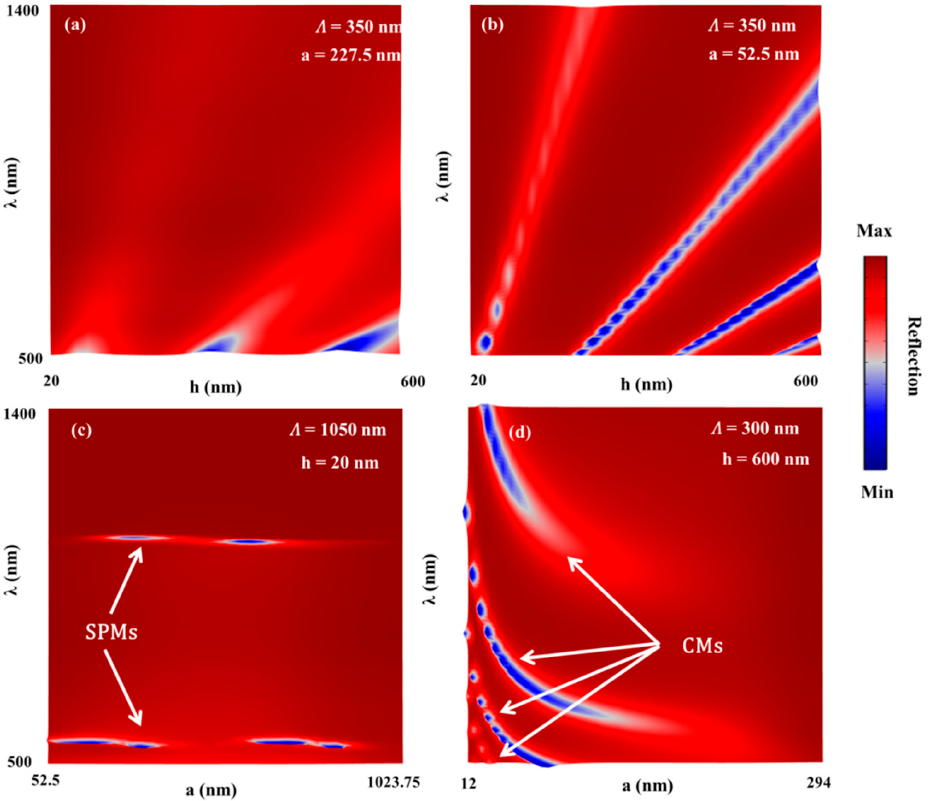
Figure 10. Reflection h- λ maps from the reflecting grating, with Λ = 350 nm. Two cases were simulated: ( a ) a = 227.5 nm, ( b ) a = 52.5 nm. Reflection a- λ maps from the reflecting grating with different combinations of the grating period ( Λ ) and thickness (h): ( c ) Λ = 1050 nm and h = 20 nm, ( d ) Λ = 300 nm and h = 600 nm. TM-polarized light under normal incidence was used in all simulations of the Ag grating. Air and Si used for the superstrate and substrate respectively.